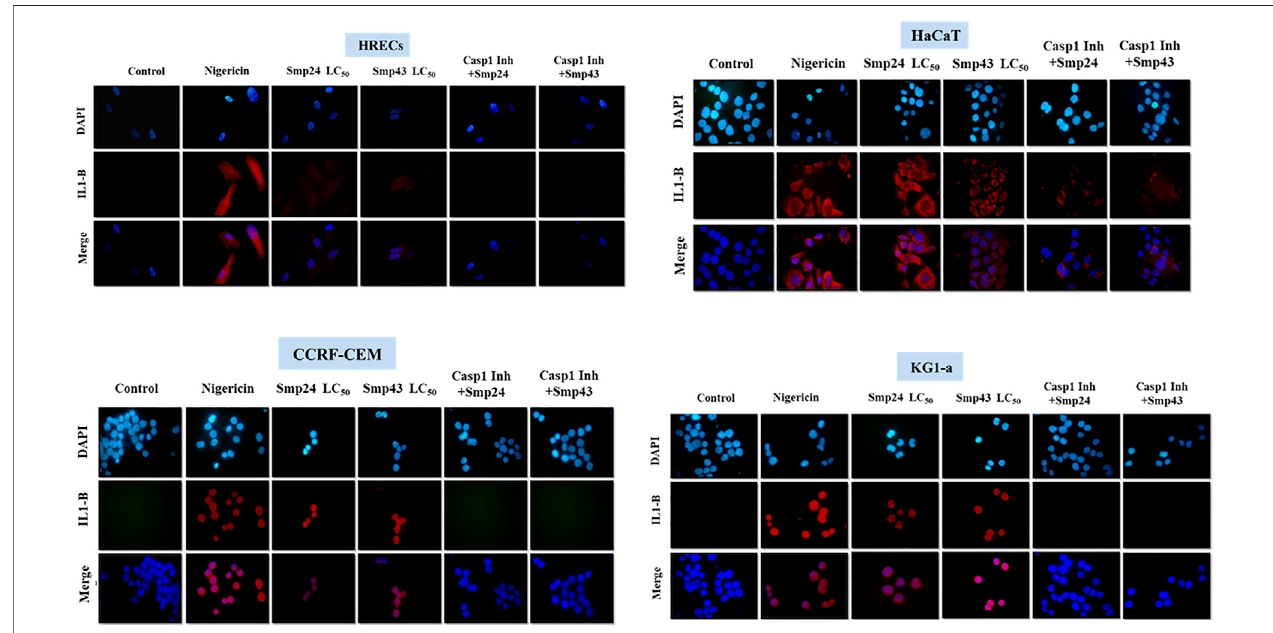
FIGURE 5 | Intracellular IL-1B localization was visualized using fl uorescence microscopy after treatment of non-tumour (HRECs and HaCaT) and tumour (CCRF- CEMandKG1-a)celllineswithSmp42andSmp43(LC 50 concentrations).CellswerestainedwithantibodyagainstIL-1BfollowedbyAlexaFluor647donkeyanti-rabbit (red colour) and countered with a Nuclear DNA dye, DAPI (blue colour)